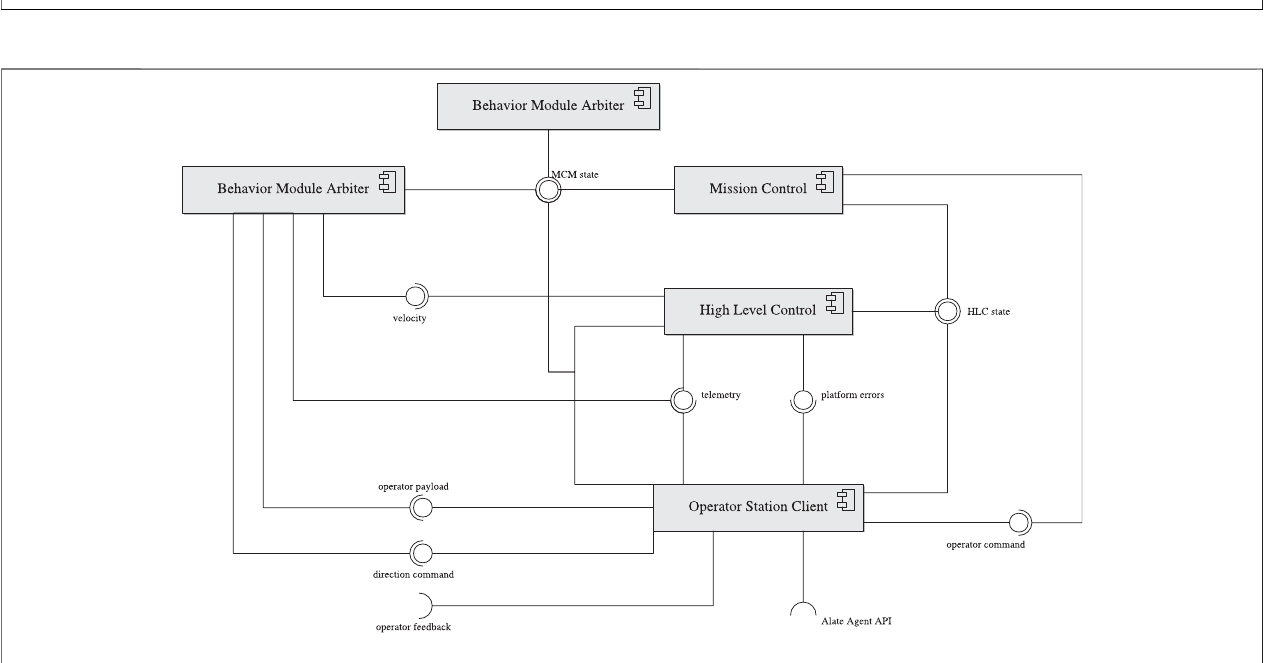
FIGURE 9 | Our algorithm implemented with TurtleBots and ROS. The agents gather to a formation resembling a rotating square (A) . The agents follow a human leader (B) . When the leader goes away, the agents eventually return to their previous formation at a new location (C) .